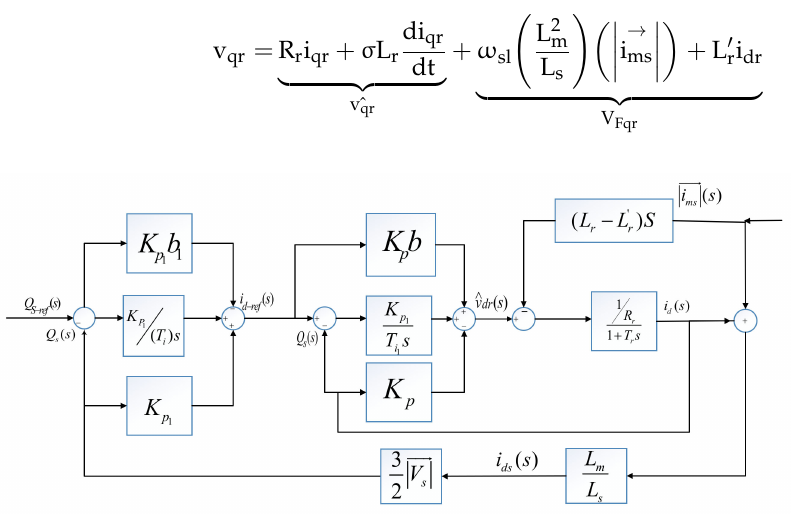
Figure 5. Control loop related to stator reactive